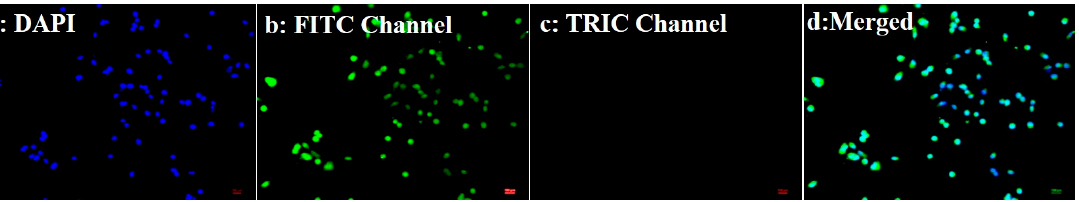
Figure 5. Fluorescence images of cellular uptake. SNU449-adsorbed free capsules.